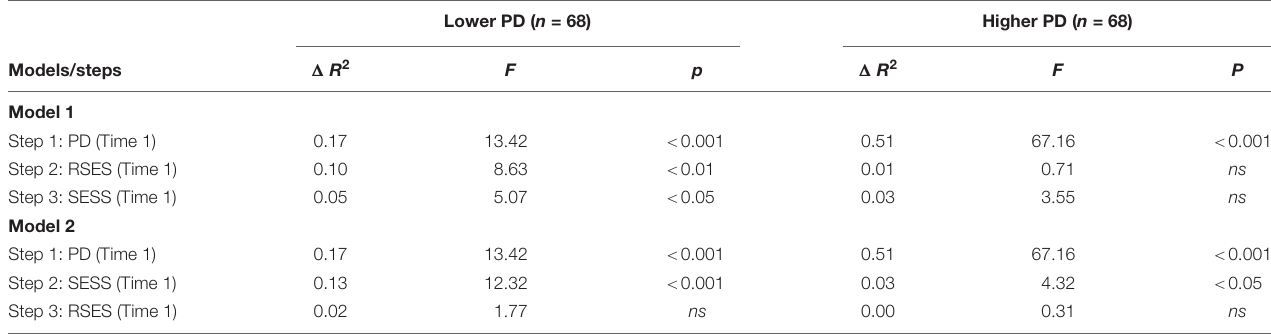
TABLE 5 | Comparisons of the RSES and SESS in the temporal prediction of psychological distress (PD) at Time 2 using multiple regression models, separated into lower versus higher PD at Time 1.